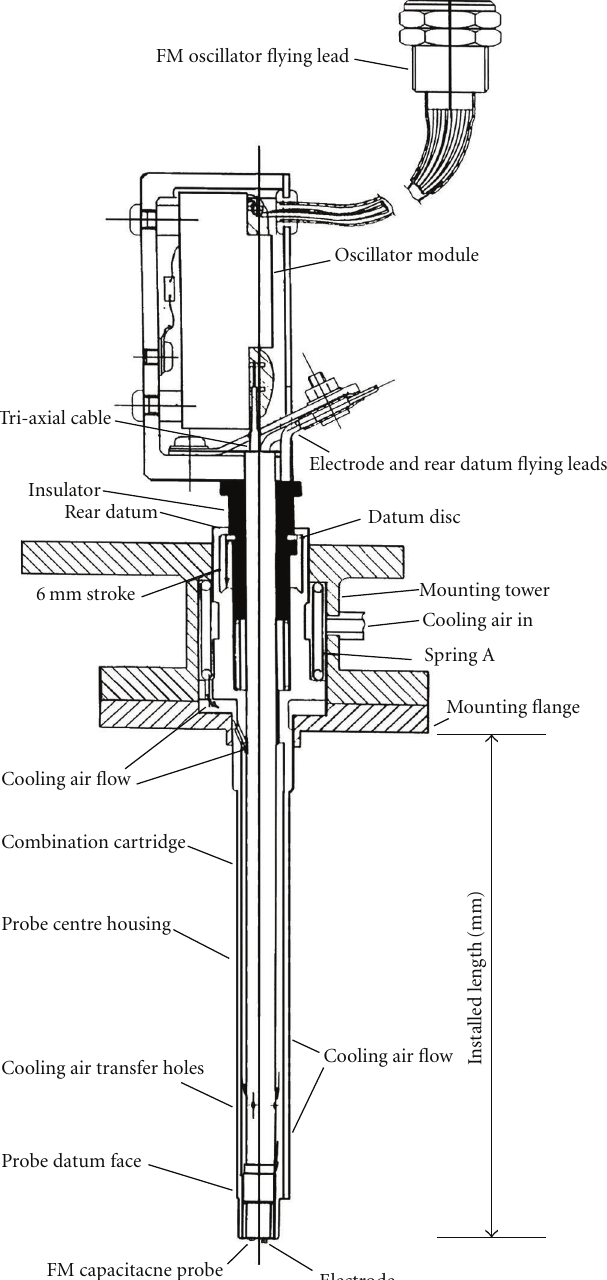
Figure 19: The hybrid probe developed by Sheard and Killeen [26] and used by Sheard and Killeen [27] to measure the blade by blade tip clearance in a high-pressure compressor